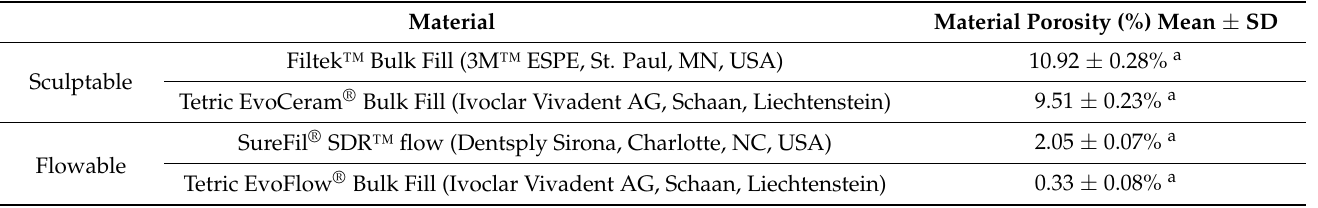
Figure 3. SEM microphotographs of the longitudinal sections of the restored teeth (white arrows are areas of good adaptation, yellow arrows are areas of moderate adaptation, red arrows are areas of inadequate adaptation and red circles are the presence of voids within the material): ( a ) Adper Easy Bond™+Filtek™ Bulk Fill (3M™ ESPE, St. Paul, MN, USA), ( b ) AdheSE ® +Tetric EvoCeram ® Bulk Fill (Ivoclar Vivadent AG, Schaan, Liechtenstein), ( c ) Prime&Bond NT ® +SureFil ® SDR ® flow+TPH Spectra ST ® (Dentsply Sirona, Charlotte, NC, USA) and ( d ) AdheSE ® +Tetric EvoFlow ® Bulk Fill+Tetric EvoCeram ® Bulk Fill (Ivoclar Vivadent AG, Schaan, Liechtenstein). Table 3. Material porosity (derived from a 3D morphometric analysis of the µ CT